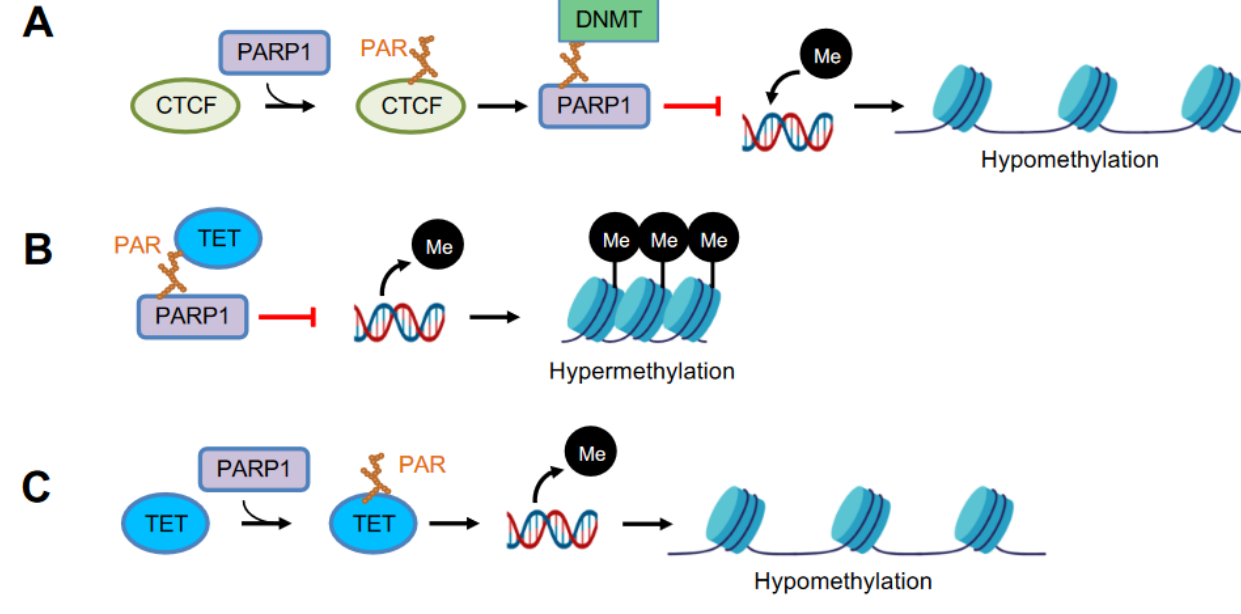
Figure 3. PARP1 modulates DNA methylation. ( A ) PARP1 PARylates chromatin insulator CTCF (CCCTC-binding factor), which in turn stimulates auto-PARylation of PARP1. Auto-PARylated PARP1 inhibits the catalytic activity of DNMT through non-covalent binding between PAR-DNMT, resulting in DNA hypomethylation. ( B ) Non-covalent binding of TET and PAR negatively regulates TET activity, resulting in DNA hypermethylation. ( C ) Covalent PARylation of TET promotes TET1 activity, causing DNA hypomethylation.